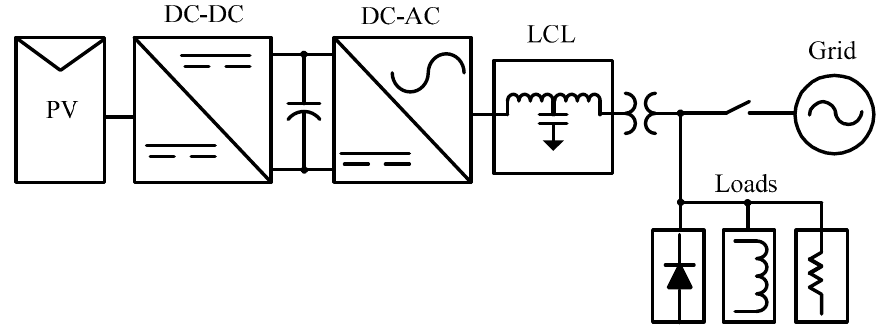
Figure 2. General PCS structure for converting PV power.